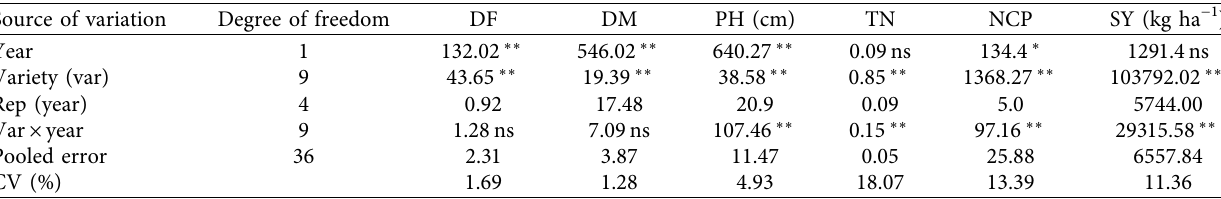
Table 3: Mean square value of combined analysis variance of yield and related traits to study linseed varieties grown in both cropping seasons (2019 and 2020).